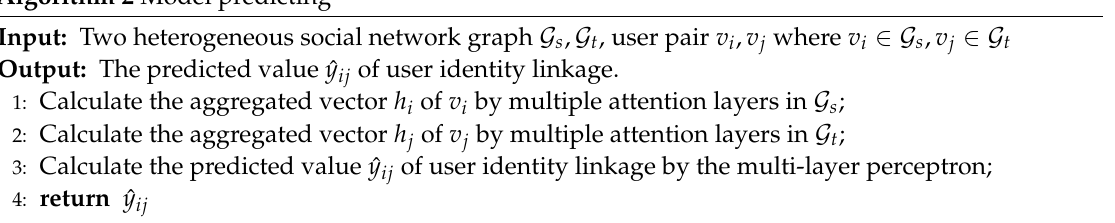
Algorithm 2 Model